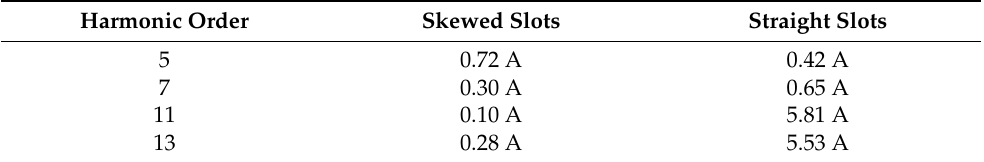
Table 2. Current harmonic amplitude at 1000 rpm and rated load.